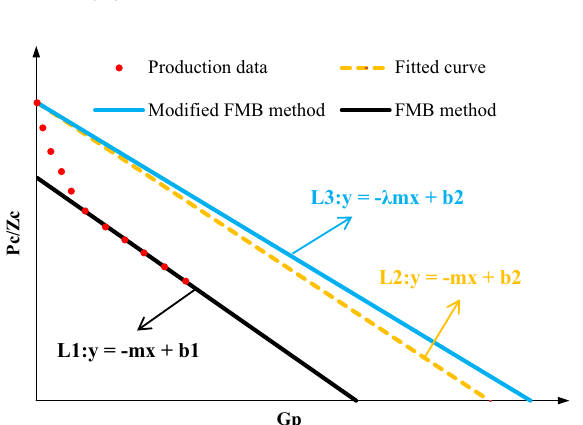
Fig. 12 P–u g C g curve of natural gas